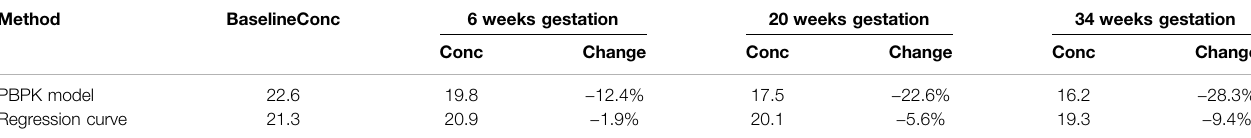
TABLE 6 | The mean steady state trough concentrations of olanzapine predicted by the PBPK model and reported TDM data-based regression curve (Westin et al.,